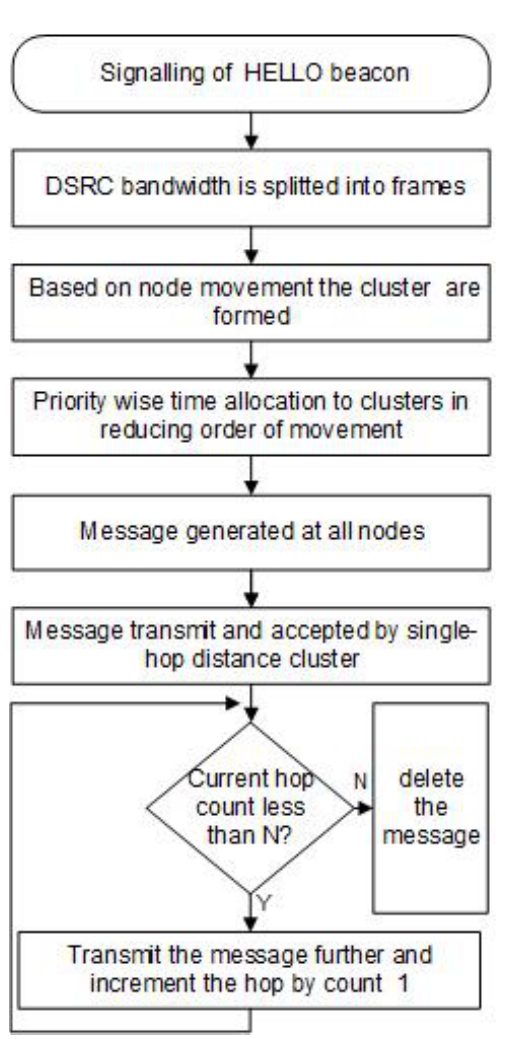
Figure 5. MAMC-MAC